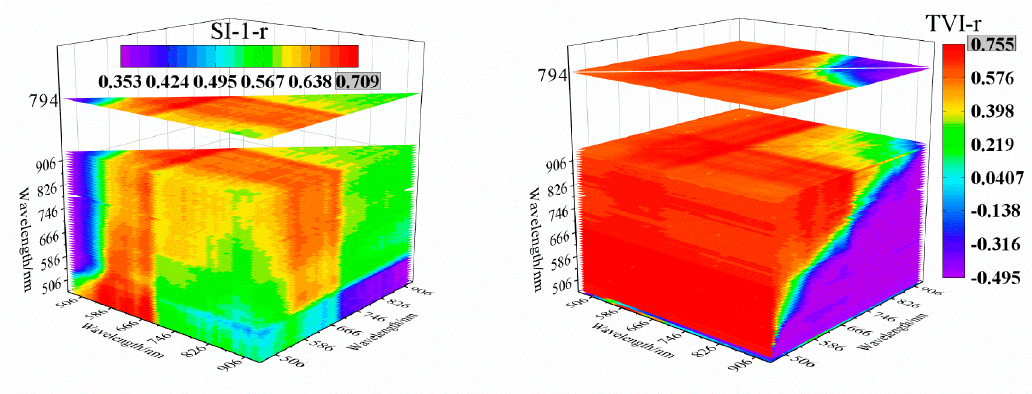
Figure 14. Three-dimensional r diagram of SMC and 0.5-order absorbance spectrum.